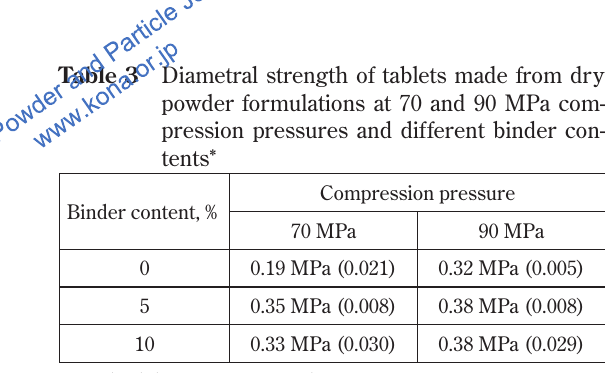
Fig. 2 Diametral strength of tablets.